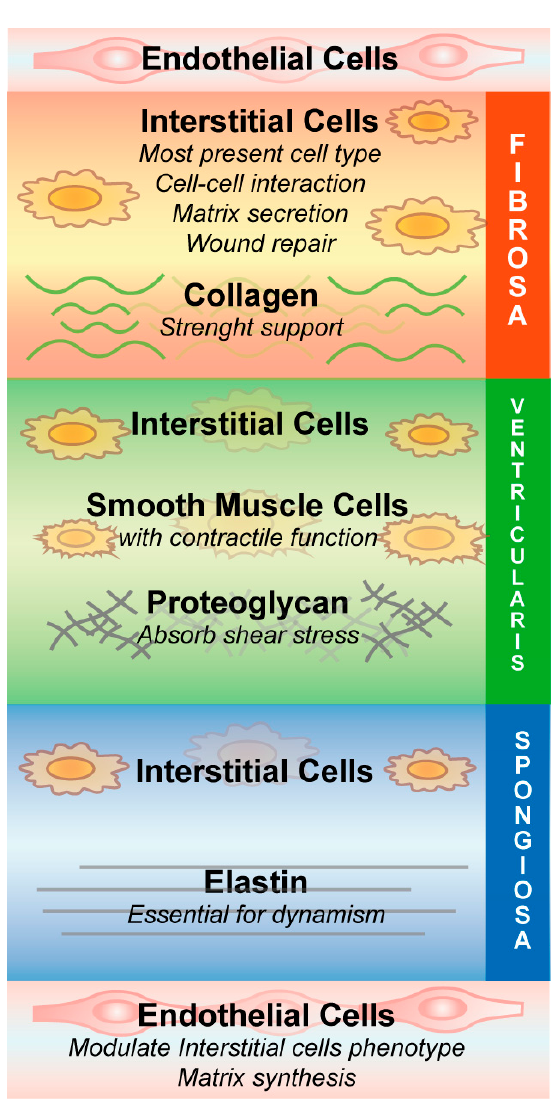
Figure 1. Aortic valve structure. Aortic valve is divided into three different layers: the fibrosa which faces the aorta, the spongiosa in the center and the ventricularis which faces left ventricular outflow tract. Valvular interstitial cells are the prevalent cell type and present in all layers. In addition, the tissue is characterized by a small percentage of smooth muscle cells and by valvular endothelial cells. All these cells are surrounded by extracellular matrix, including collagen, proteoglycan and elastin.